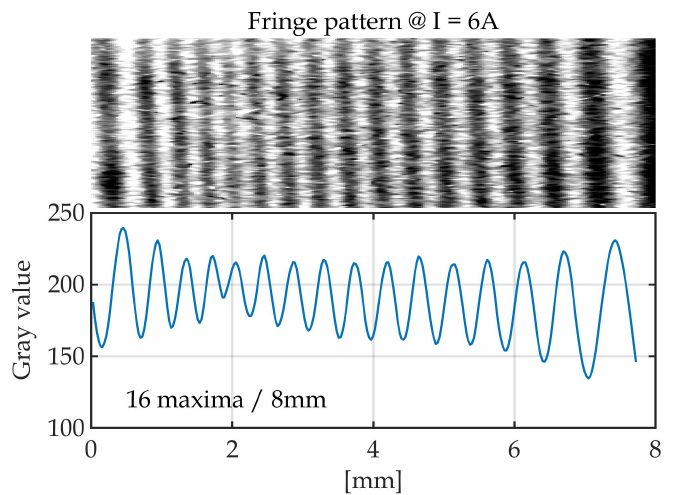
Figure 13. Part of Figure 11, image I = 6[A], under-laid by the line plot showing the varying contrast in the